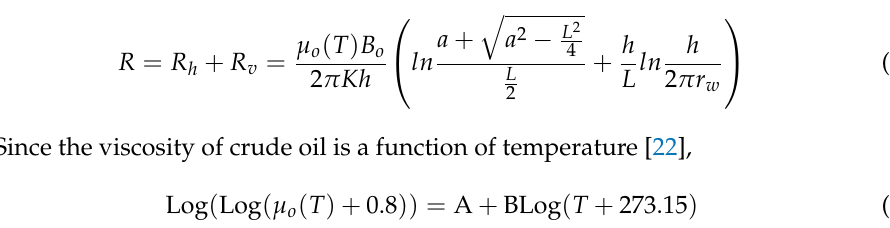
where A and B are factorless coefficients, and it is a contant value for the specific crude oil, the results of the viscosity–temperature experimental test are regressed. In this article, A of heavy oil in the target area is 9.26, and B is − 3.44. Substitute the values of A and B into the Formula (15) and get it by transformation: